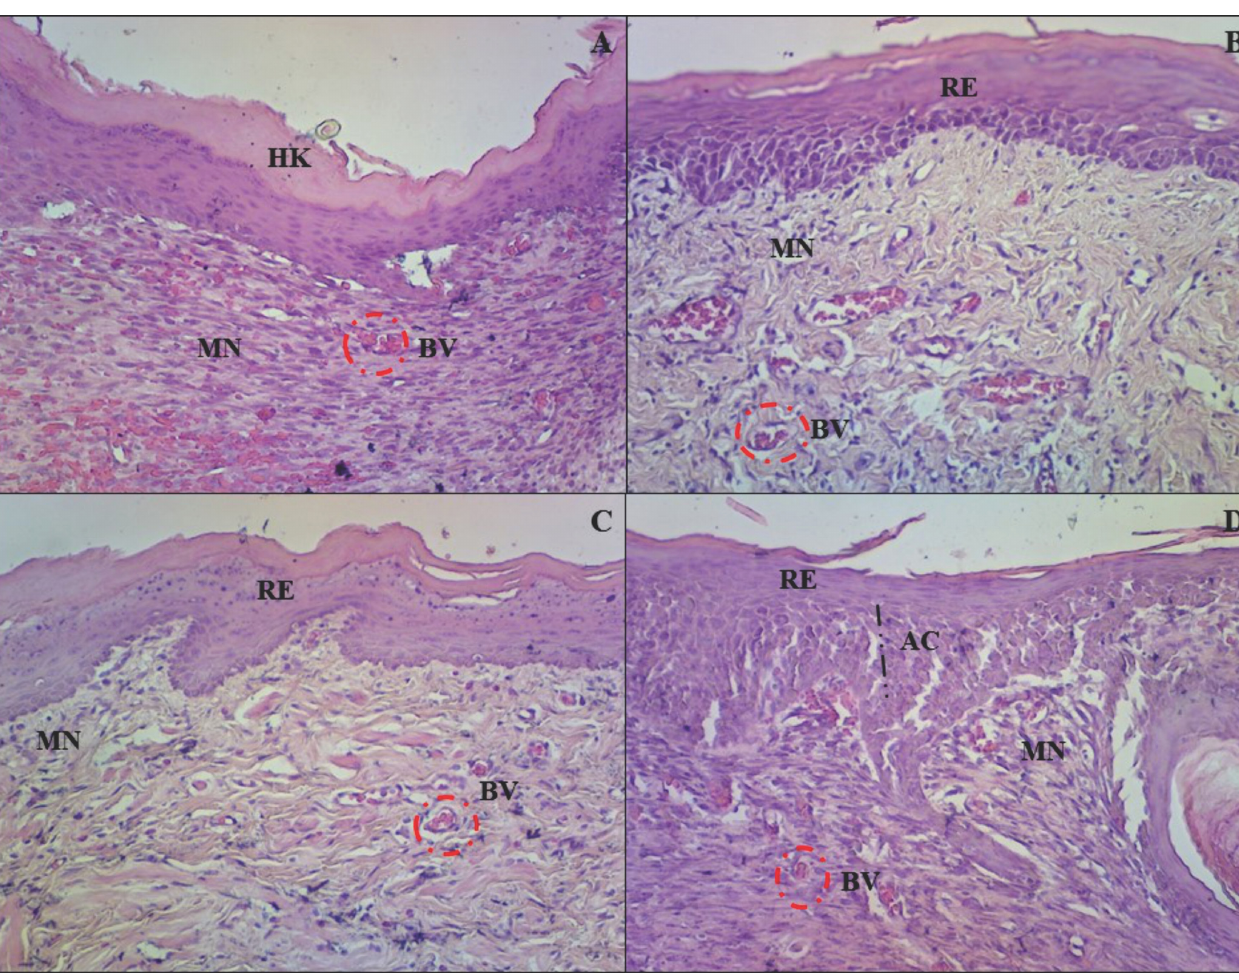
FIGURE 5 - Microscopic aspects of groups at fourteen days of experimentation. A Group treated with gel base (Borneol 0%); B Group treated with gel (Borneol 1.2%); C Group treated with gel (Borneol 2.4%); and D Group (Control). RE-=reepithelialization; HK=Hyperkeratinization; BV=Blood Vessel; MN=Mononuclear; AC=acanthosis. Magnification x10. HE